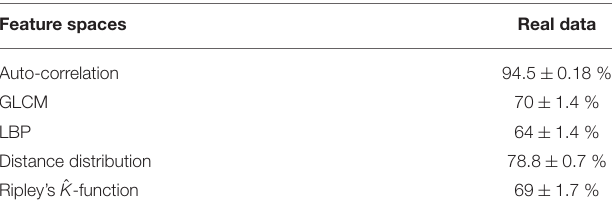
TABLE 1 | Classification results of the studied methods applied to real data set of Figure 2A . Feature spaces